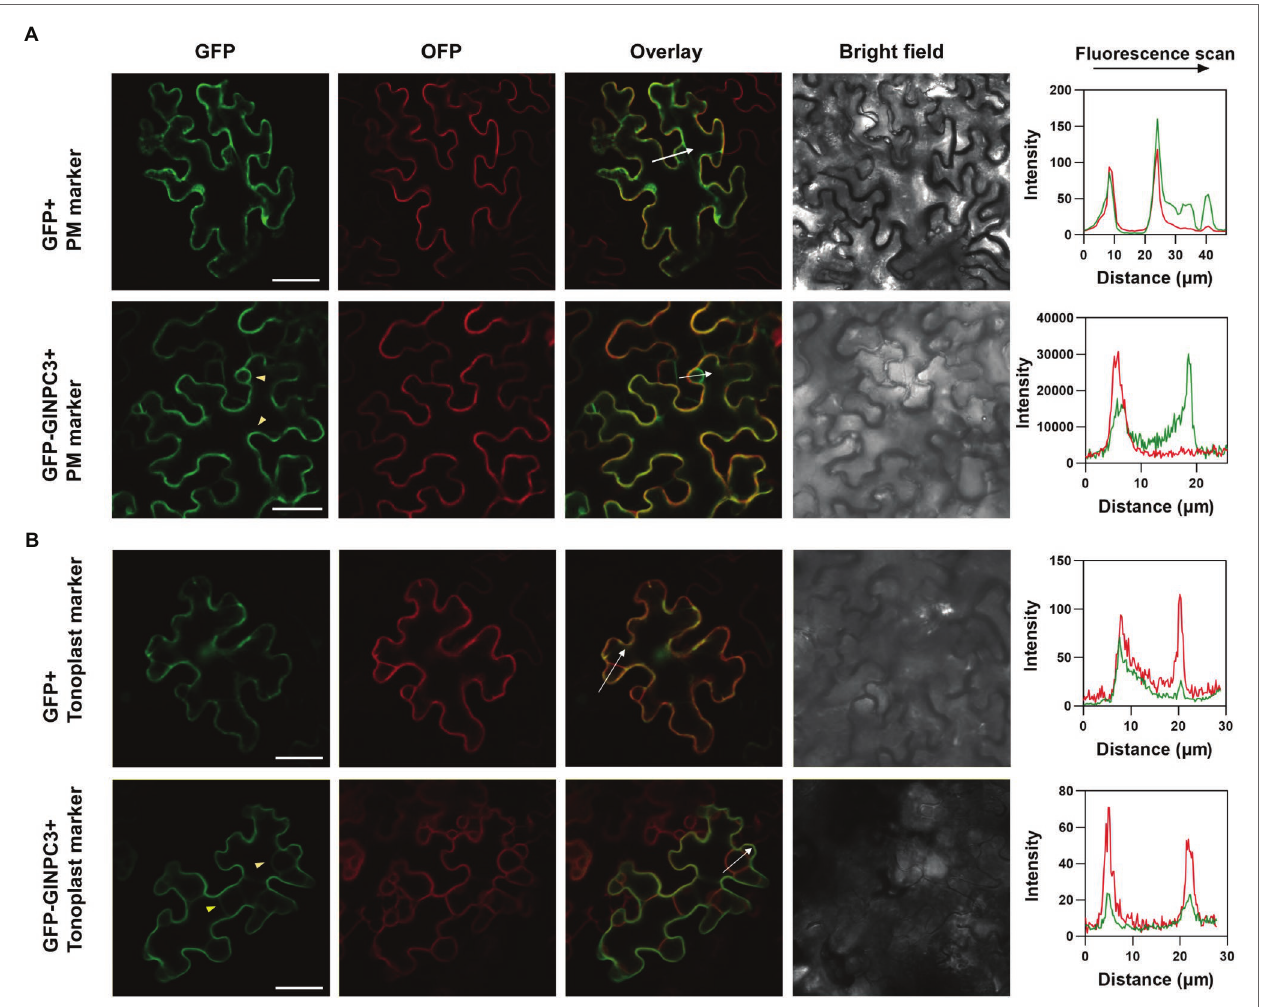
FIGURE 5 | Subcellular localization of GlNPC3 in leaf epidermal cells of N. benthamiana . (A) Upper row, GFP empty vector was co-expressed with a plasma membrane (PM) marker. Lower row, GFP-GlNPC3 fusion protein was co-expressed with the PM marker. PM marker, AtCBL1n-OFP. Bars, 40 μ m. The fluorescence intensity profiles along the direction of white arrows were obtained using Zen (blue edition). The yellow arrow heads indicate the PM and tonoplast localization of GlNPC3. (B) Upper row, GFP empty vector was co-expressed with the tonoplast marker. Lower row, GFP-GlNPC3 fusion protein was co-expressed with the tonoplast marker. Tonoplast marker, AtCBL6-OFP. Bars, 40 μ m. The fluorescence intensity profiles along the direction of white arrows were obtained using Zen (blue edition). The yellow arrow heads indicate the tonoplast localization of